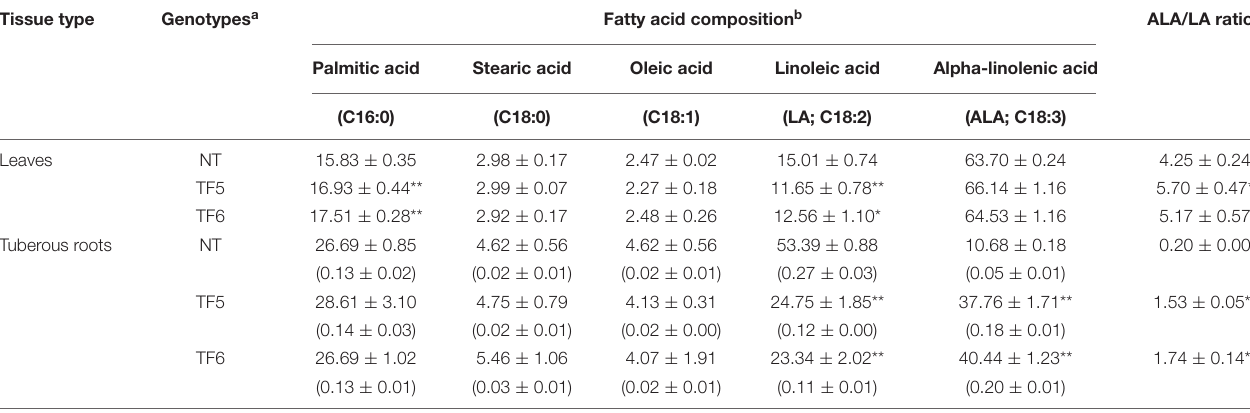
TABLE 1 | Fatty acid composition of the leaves and tuberous roots of sweetpotato plants. Tissue type Genotypes